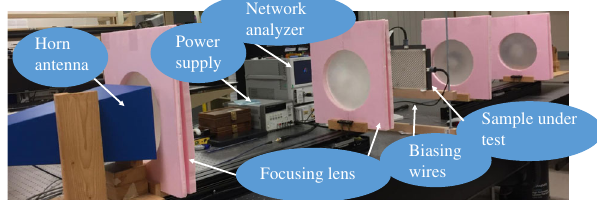
FIG. 9. Photograph of the quasioptical, free-space measurement